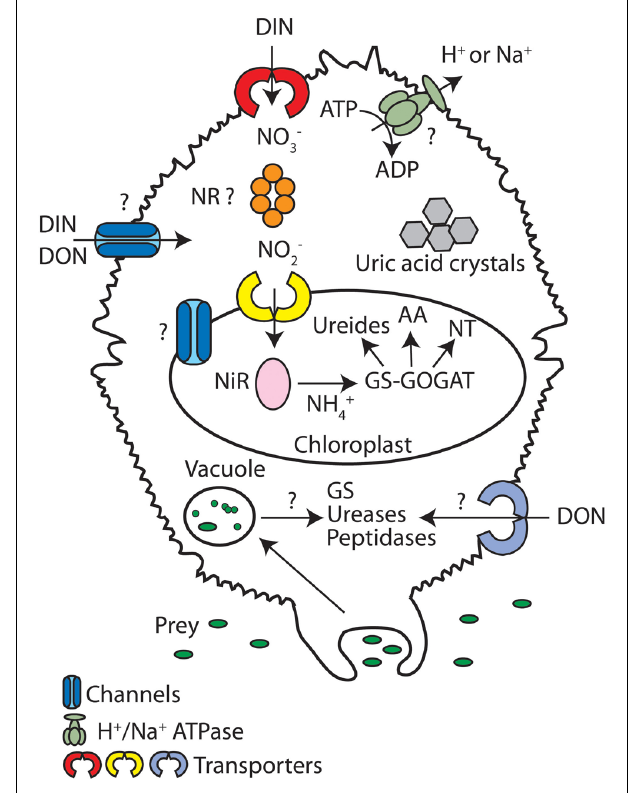
FIGURE 1 | Nitrogen metabolism in dinoflagellates. In this schematic overview of N metabolism, transporters and channels are depicted as individual proteins that transport a range of N forms, even though transporters/channels are normally selective for particular N forms. A (?) signifies that the pathways or proteins have not been reported in dinoflagellates, but can be present in other photosynthetic eukaryotes.The (NR ?) indicates that while this enzyme is usually localized to the cytoplasm, a study in L. polyedrum indicated it was found to the chloroplast (Fritz etal., 1996). AA, amino acids; DIN, dissolved inorganic nitrogen; DON, dissolved organic nitrogen; GS, glutamine synthetases; GOGAT, glutamine 2-oxoglutarate amidotransferase; NH + 4 , ammonium; NO − 3 , nitrate; NO − 2 ; nitrite; NiR; nitrite reductase; NR, nitrate reductase; NT,